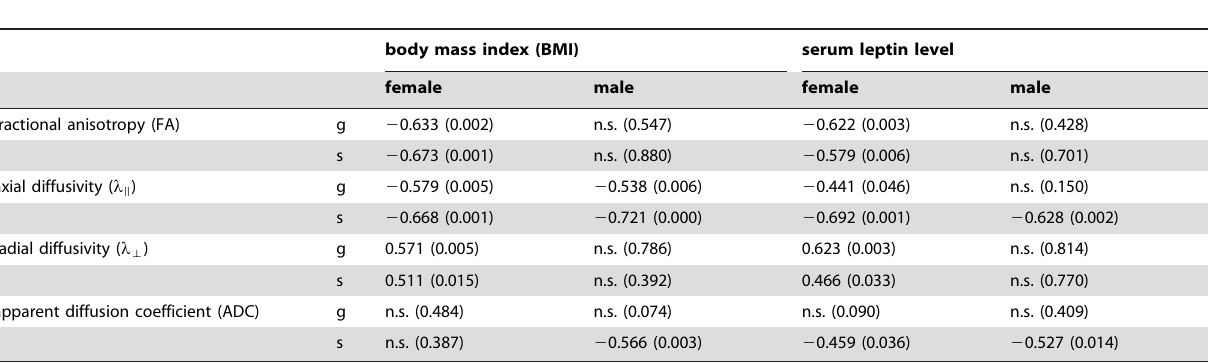
Table 1. Correlation coefficients (and p -values) between diffusion and obesity parameters as obtained from region-of-interest (ROI) analyses in the genu (g) and splenium (s) of the corpus callosum (n.s.=not